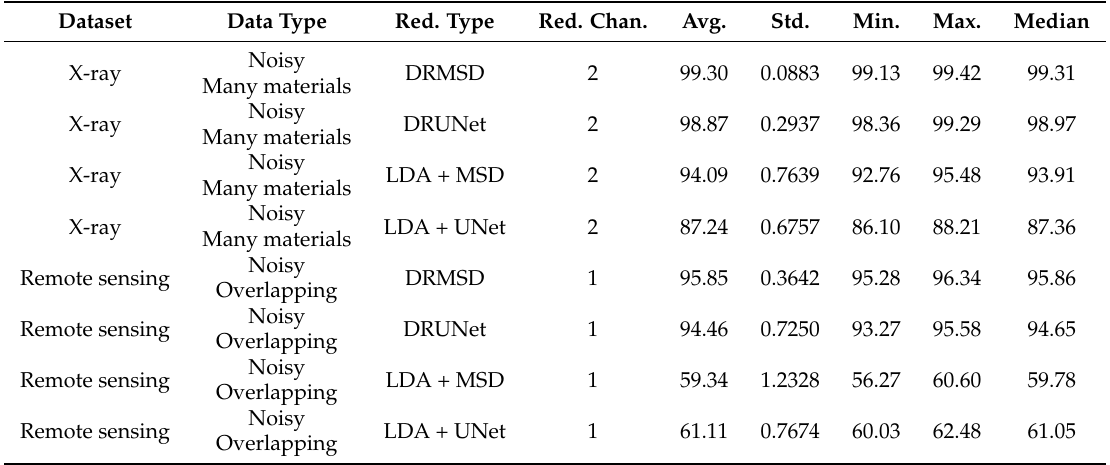
Table A1. Average, standard deviation, minimum, maximum and median of the average class accuracy for various network setups, computed over 8